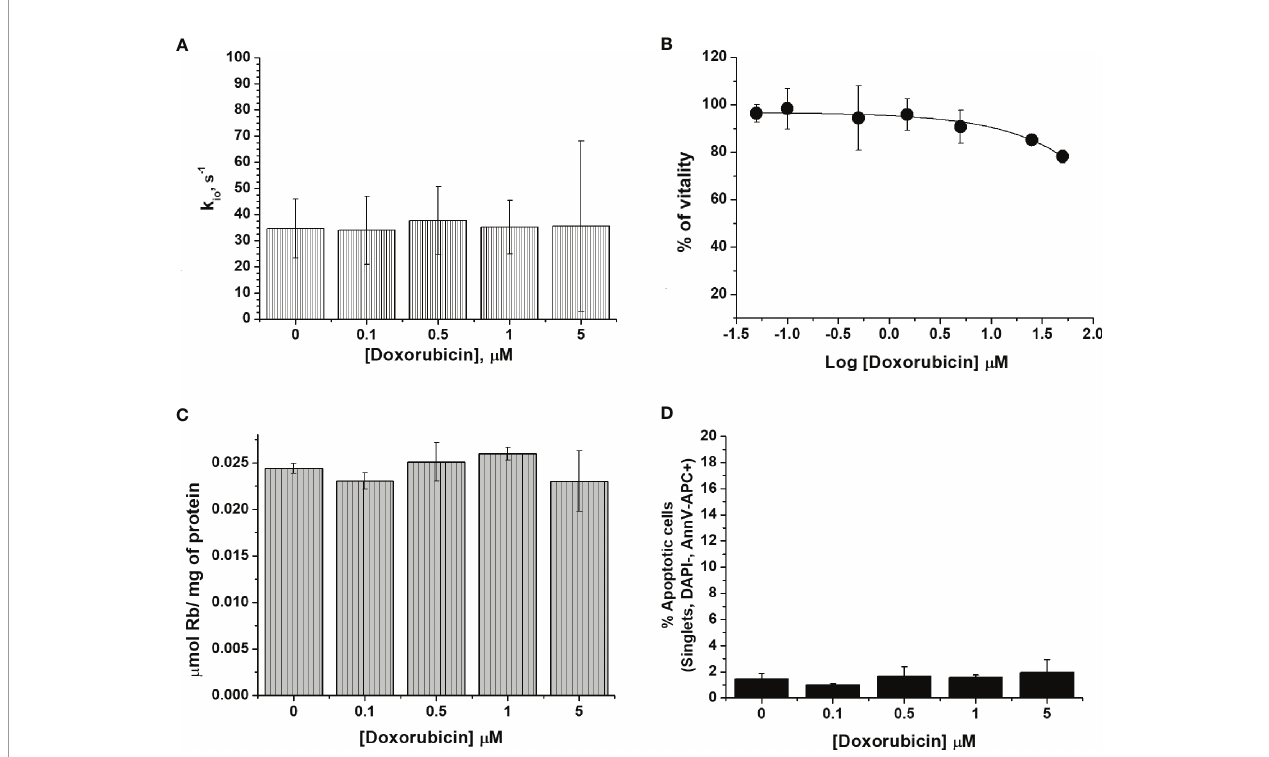
FIGURE 2 | The characterization of 4T1-R cells. (A) The cellular water ef fl ux rate constant, k io (s -1 ), determined 24 h after doxorubicin treatment at different drug concentrations (0.1-5 µM). k io values were determined by measuring the water proton relaxation times of cell suspensions in the presence of 10 mM of Gd-HPDO3A at 25°C on a fi xed frequency spectrometer operating at 0.5 T. Data are expressed as the mean ± SD with n= 4. (B) Percentage of viable cells as determined using the MTT test and plotted vs Log[Doxorubicin] µM. Data are expressed as the mean ± SD of three independent experiments. (C) Cellular uptake of Rb (µmol of Rb/ mg of protein) measured 24 h after doxorubicin treatment. The cells were suspended in a medium containing RbCl 0.12 mM for 1 h at 37°C and 5% of CO 2 . Data are expressed as the mean ± SD of three independent experiments. (D) Determination of the % of apoptotic cells after doxorubicin treatment at different concentrations. The percentage of apoptotic cells was assessed by DAPI-, AnnV-APC+ staining using FACS analysis. Data are expressed as the mean ± SD of three independent